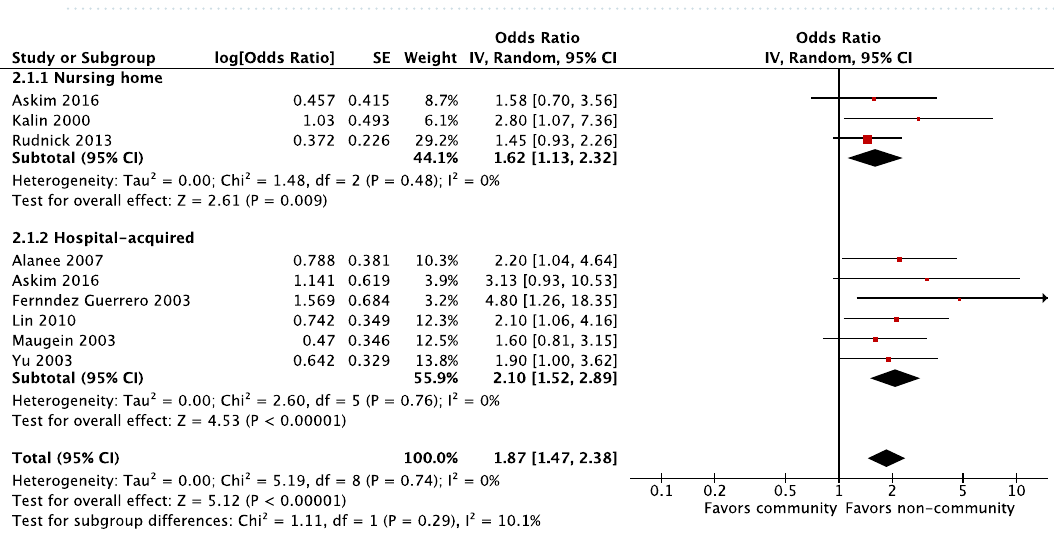
Figure 3. Risk factor of septic shock.